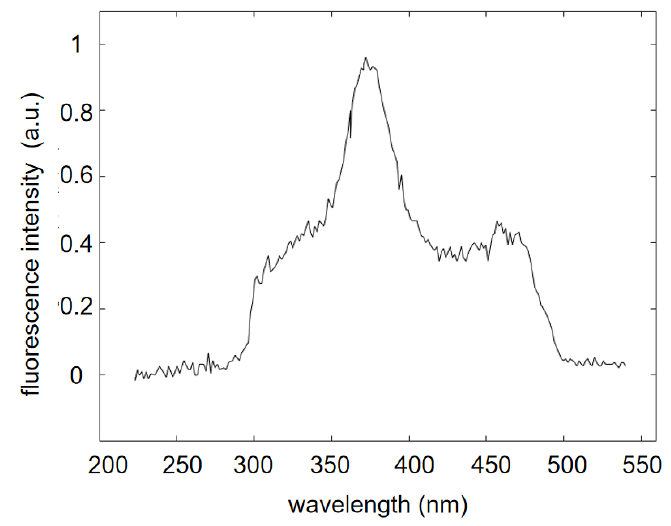
Figure 1. The spectrum of Tm-doped fiber pumped by laser at 793 nm.